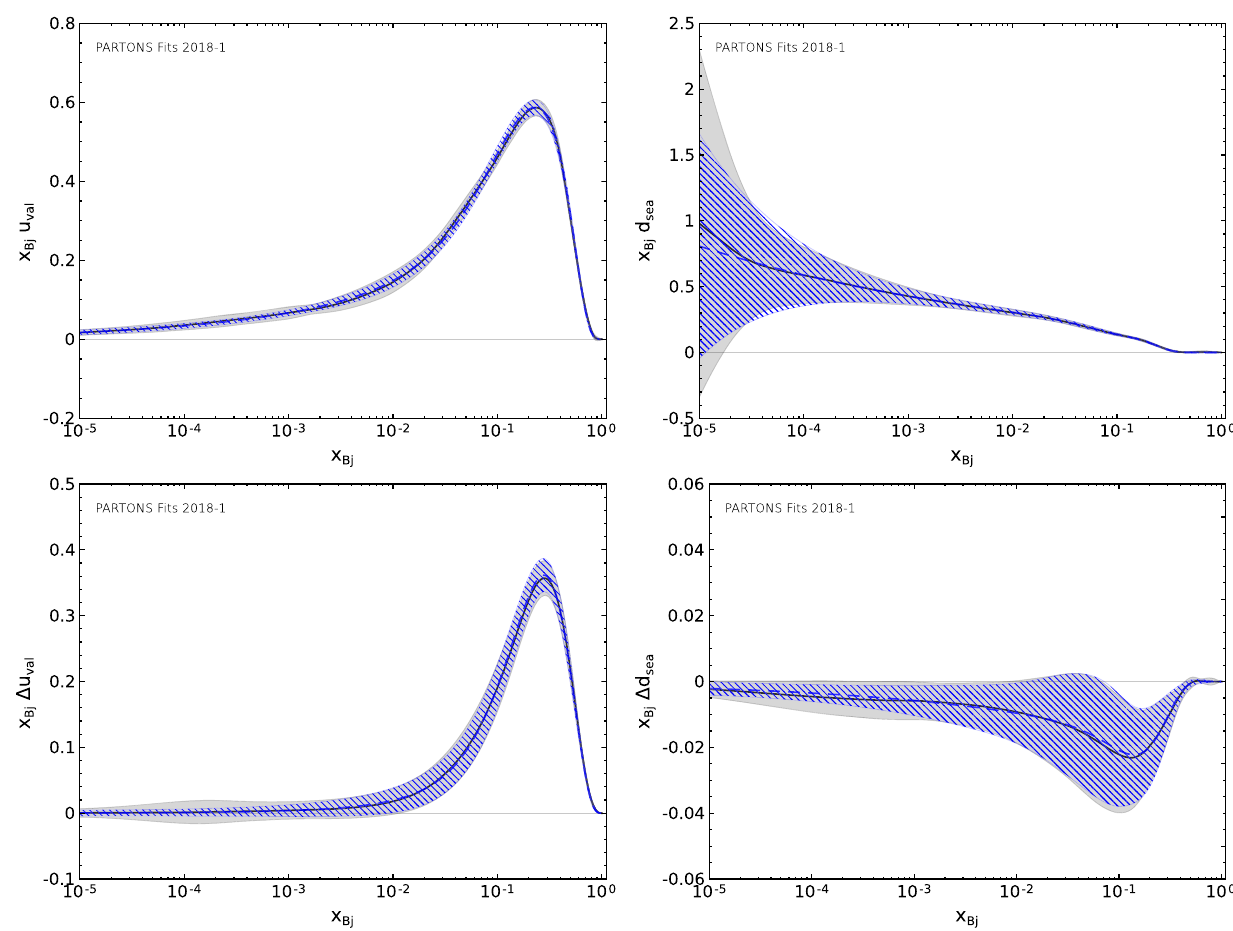
curve with the grey band representing 68% confidence level is for PDFs by NNPDF group, while the blue dashed curve with the hatched band is for our fit. The curves are evaluated at Q 2 = 2 GeV